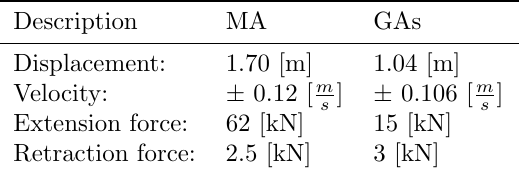
Table 3: Actuator requirements.